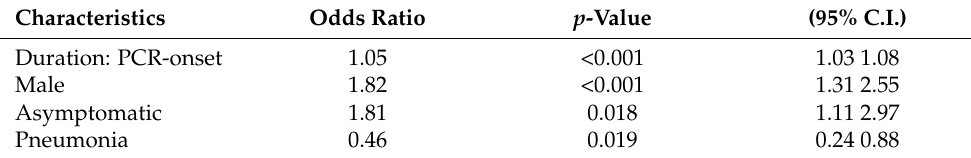
Table 5. Multivariate logistic regression for viral